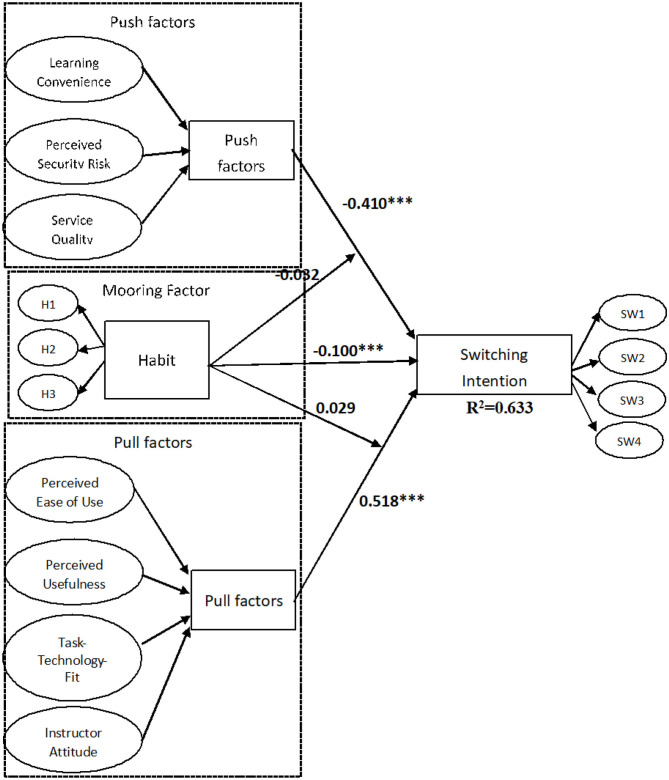
PLS results of the research model.